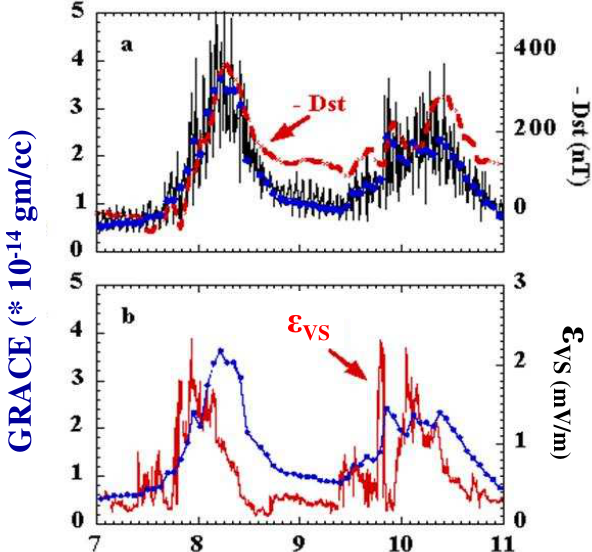
Fig. 2. (a) The black trace indicates mass densities measured by GRACE on 7–10 November 2004 at 10s resolution. The red dashed line shows variations of − D st over this period. Blue dots in both panels mark orbit-averaged densities. (b) The red trace indicates the electric field in the equatorial plane of the inner magnetosphere estimated from ACE measurements at L 1